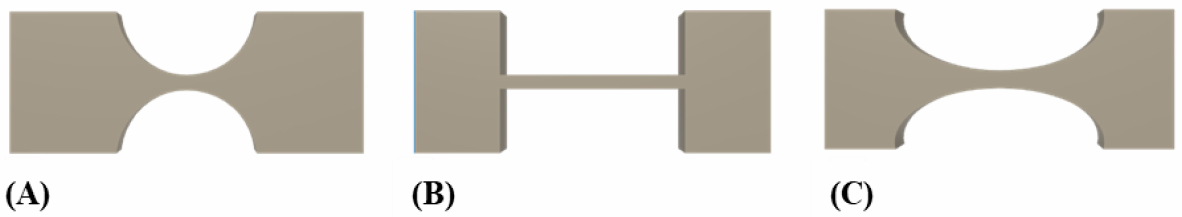
Figure 4. ( A ) Notch hinge; ( B ) Blade hinge; ( C ) Elliptical hinge.